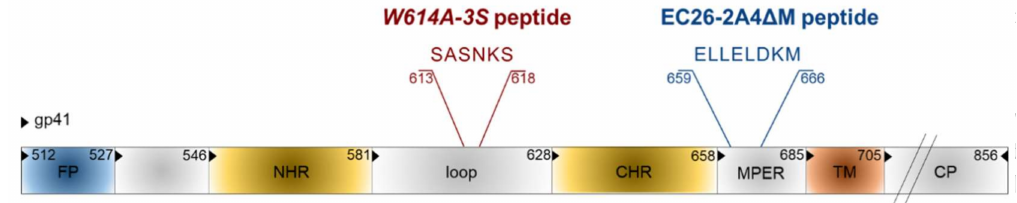
Figure 7. Epitope vaccine candidates in gp41. Functional domains are FP: fusion